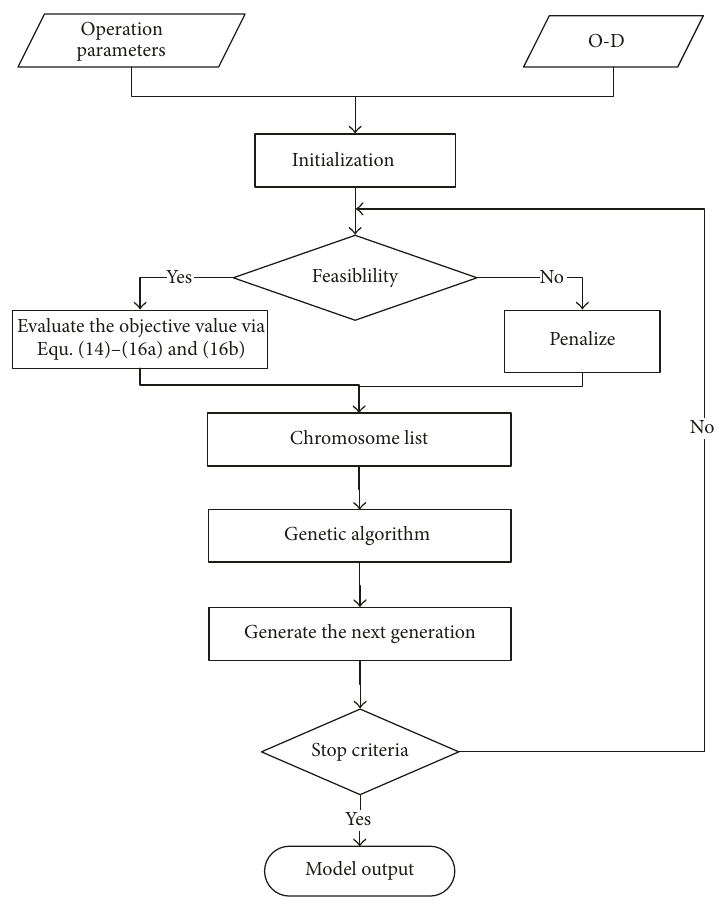
Figure 5: A GA-based solution